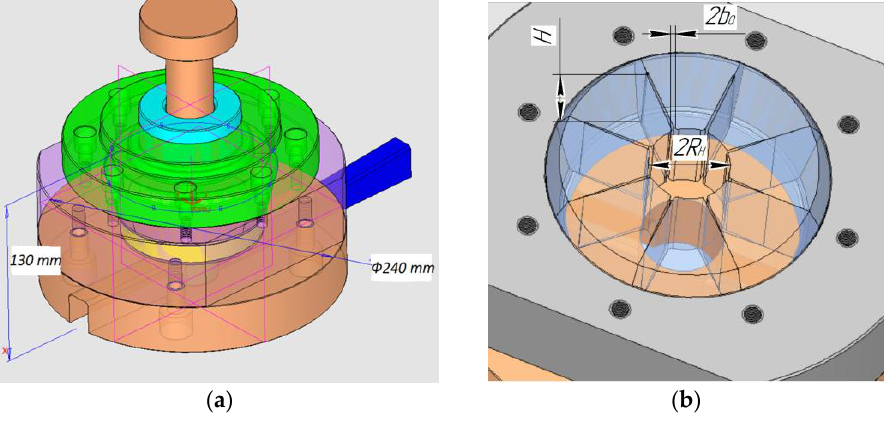
Figure 7. Die: ( а ) Assembled representation; ( b ) Bottom die. Figure 7. Die: ( a ) Assembled representation; ( b ) Bottom die. Measured dimensions of the forgings are summarized in Table 1. Table 1. Size of the replaceable blocks of the die. Table 1. Size of the replaceable blocks of the die.